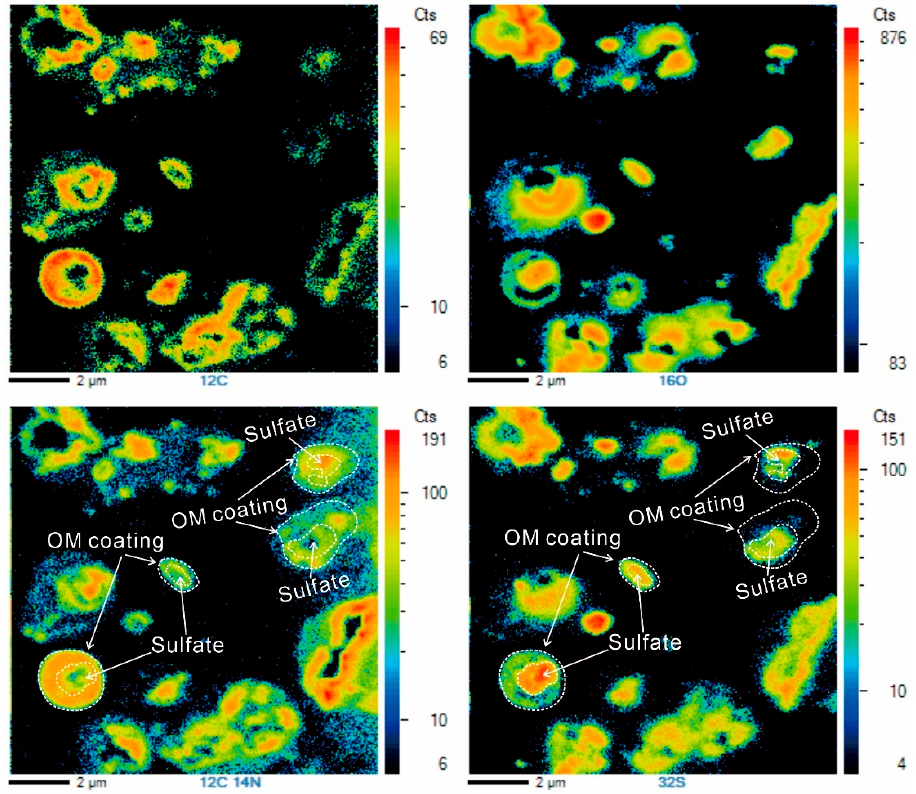
Figure 4. Particles of nanoscale secondary ion ( 12 C − , 16 O − , 12 C 14 N − and 32 S − ) intensity distribution at